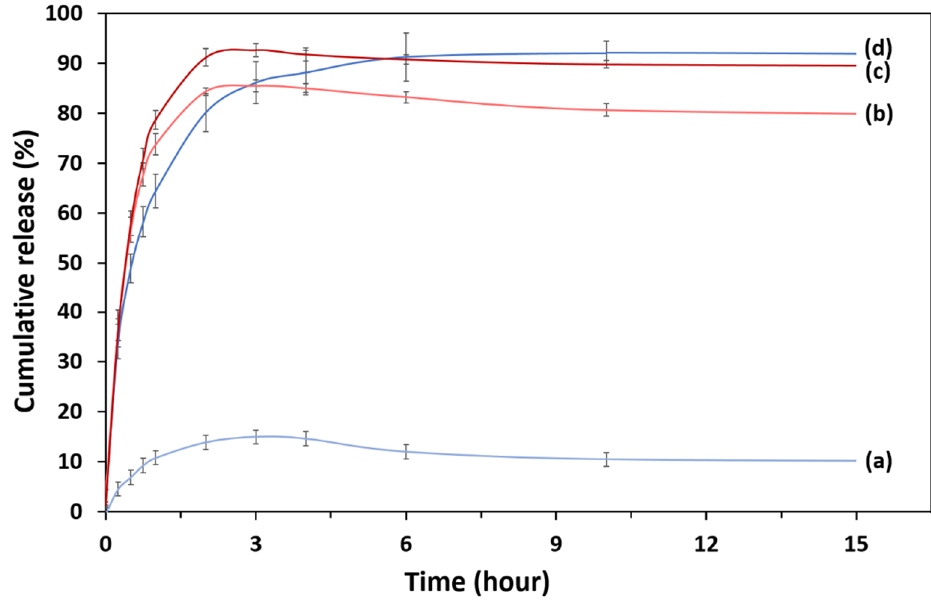
Figure 9. Drug release profile of ( a ) MMT/CR/Fe 3 O 4 -PCA at pH 7.4, ( b ) PCA at pH 7.4, ( c ) PCA at pH